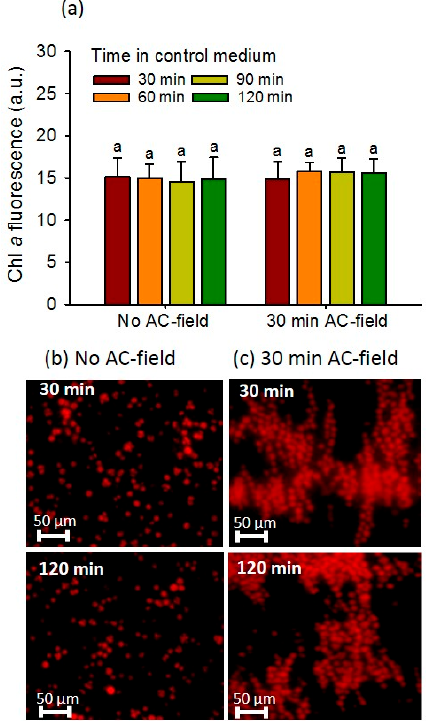
Figure 2. Effect of the AC-field duration on chlorophyll fluorescence intensity of 2D-cellular arrays. ( a ) Fluorescence intensity corresponding to the mean corrected fluorescence intensity ( CF ) per pixel calculated from the fluorescence images obtained in DAPI channel with or without the application of AC-field. The letter ‘a’ indicates the non-statistically significant differences and were obtained by Student–Newman–Keuls test with p < 0.05. Microscopy images of autofluorescent 2D-arrays with ( b ) no AC-field and ( c ) AC-field applied for 30 min. The initial concentration of algae in suspensions was 5 × 10 6 cells mL − 1 .